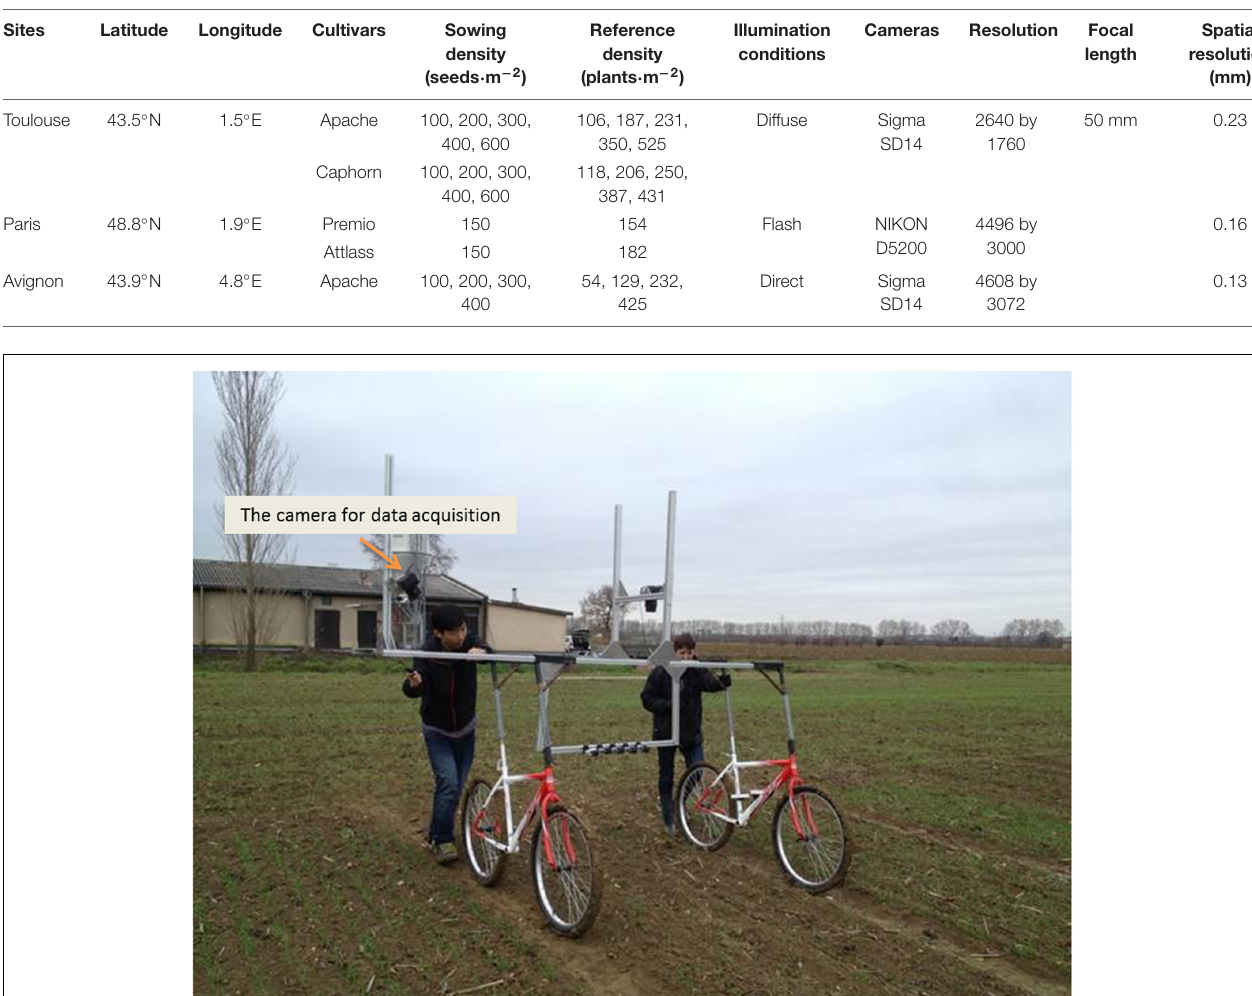
TABLE 1 | Characteristics of the three experimental sites.